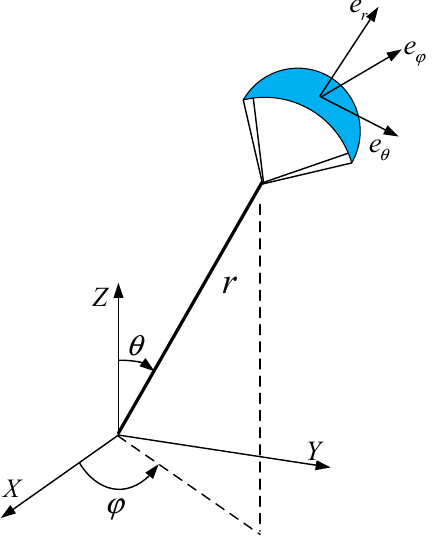
Figure 1. Parafoil in the ground coordinate system.